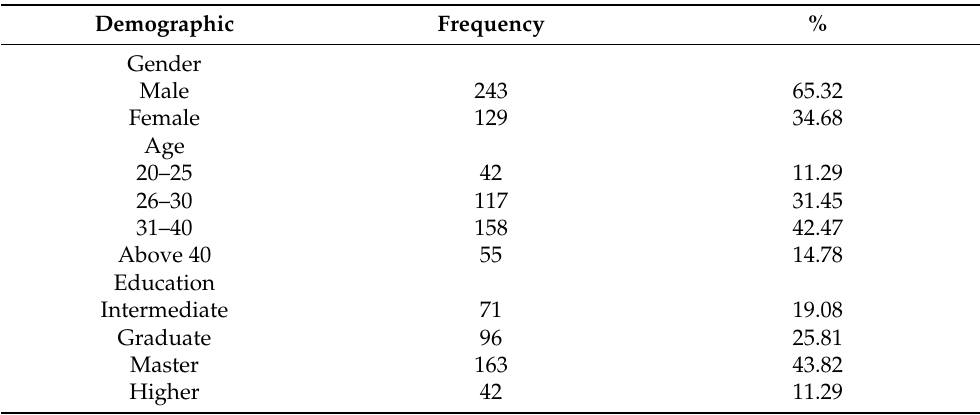
Table 2. Demographic information of the